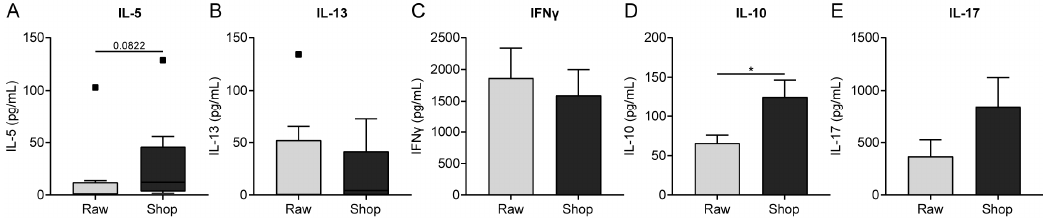
Figure 6. Cytokine concentrations produced by ovalbumin (OVA) ‐ stimulated splenocytes corresponded with observed histone acetylation. ( A ) IL ‐ 5, ( B ) IL ‐ 13, ( C ), IFN γ , ( D ) IL ‐ 10 and ( E ) IL ‐ 17 concentrations measured in supernatant after ex vivo stimulation of splenocytes with OVA for four days (37 °C, 5% CO 2 ). Data are presented as box ‐ and ‐ whisker Tukey plot (in which outliers are shown as separately plotted points) for IL ‐ 5 and IL ‐ 13 concentrations and as mean ± standard error of the mean for IFN γ , IL ‐ 10 and IL ‐ 17 concentrations after subtracting baseline cytokine levels, n = 8/group. * p < 0.05 as analyzed with a Mann ‐ Whitney test ( A, B ) or an unpaired two ‐ tailed Student’s t ‐ test ( C– E ). OVA, ovalbumin; raw, raw cow’s milk; shop, shop milk.